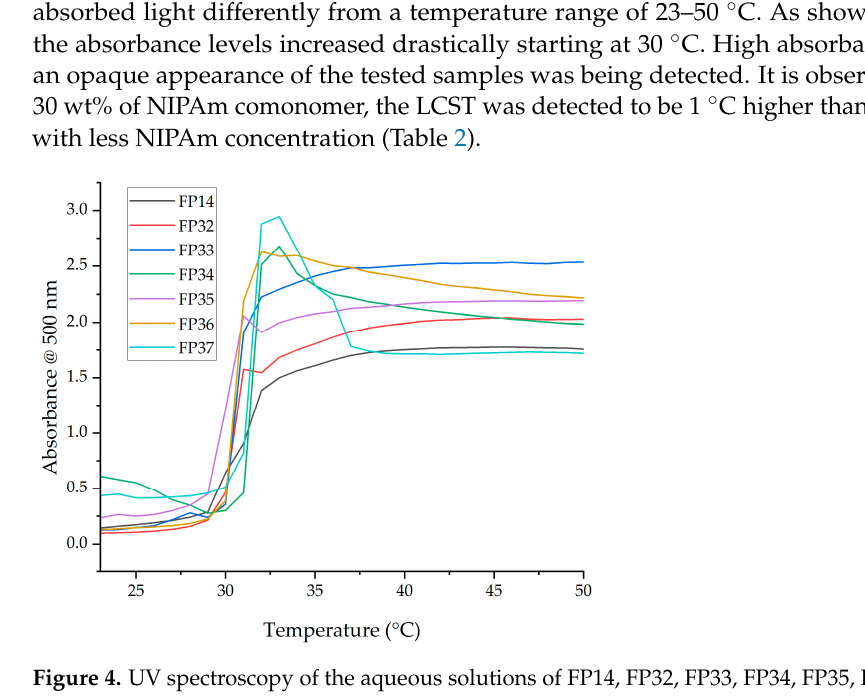
Figure 5. A representative DSC heating curve of a fully swollen chemically crosslinked hydrogel for analyzing its LCST.